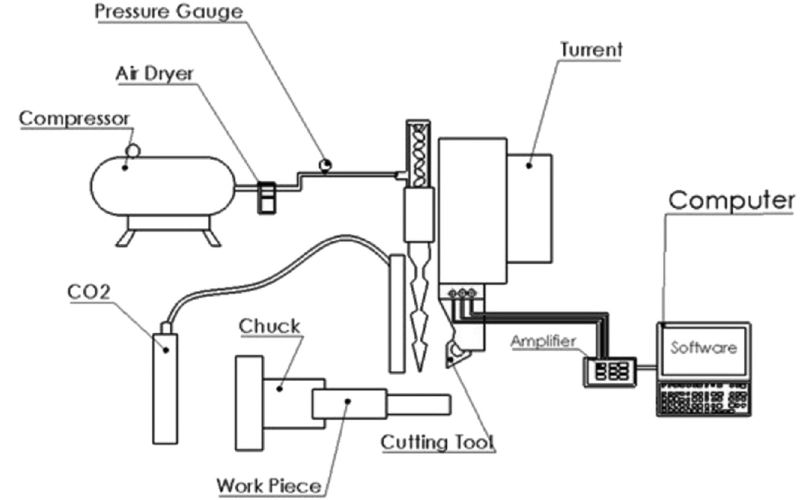
Figure 1: Experimental setup.